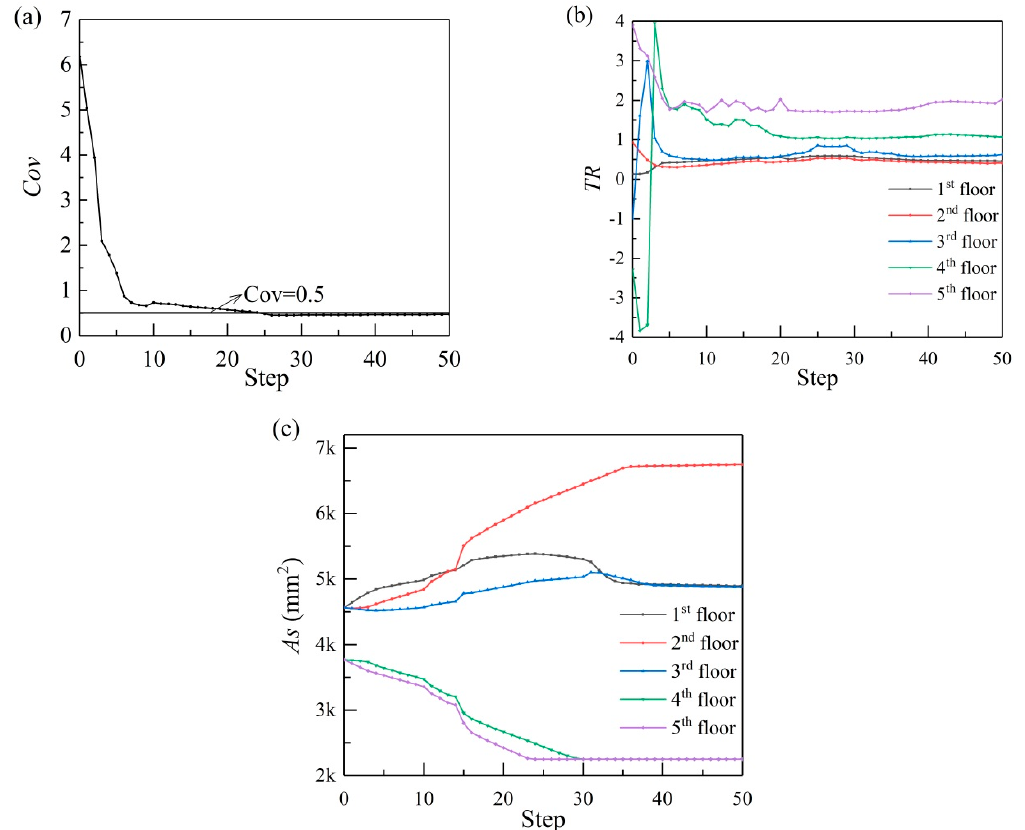
Figure 5. Variation of Cov , TR , and As from CSBDC-based structure tending to final optimization solution: ( a ) coefficient of variation TR , ( b ) TR for each floor, ( c ) longitudinal reinforcement dimension of single column for each floor (Earthquake: San Fernando, 1971, RSN68).